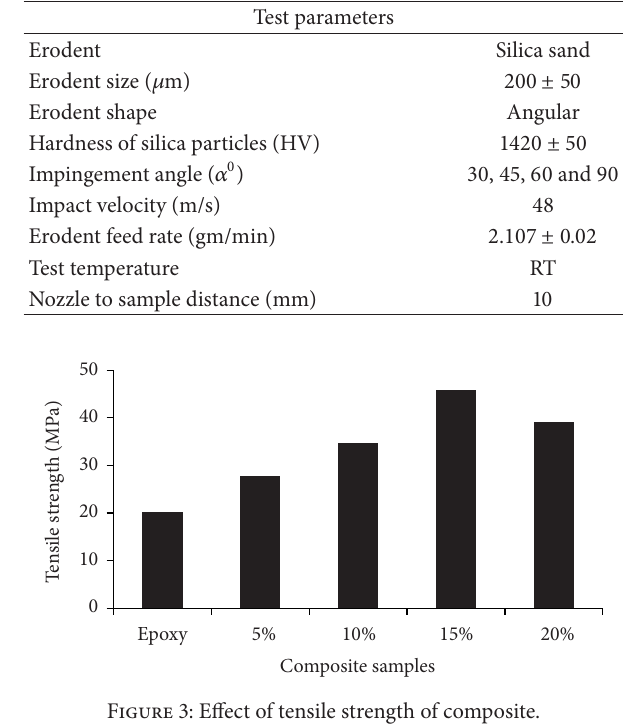
Figure 3: Effect of tensile strength of